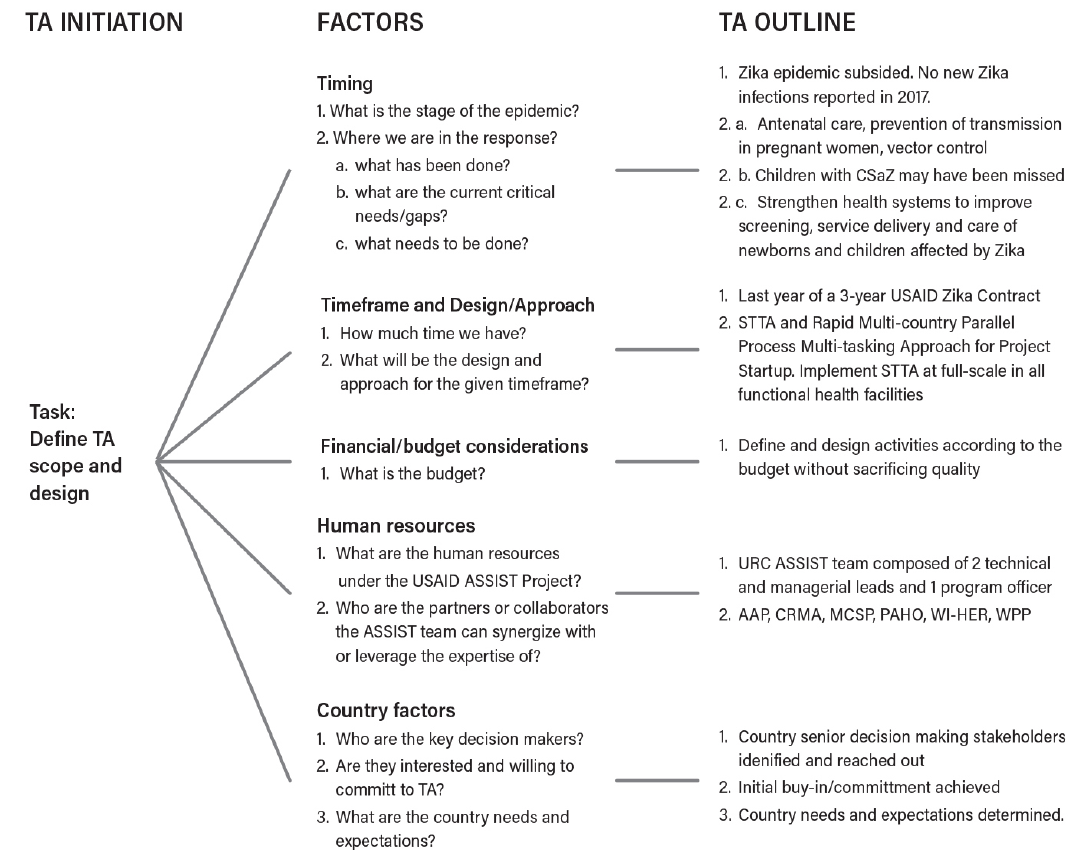
Figure 3. Key determining factors for the STTA focus, scope and approach. TA, technical assistance; CSaZ, congenital syndrome associated with Zika; STTA, short-term technical assistance; MCSP, USAID Maternal and Child Survival Program; AAP, American Academy of Pediatrics; CRMA, Caribbean Regional Midwives Association; PAHO, Pan American Health Organization; WI-HER LLC, Women Influencing Health, Education, and Rule of Law; URC, University Research Co., LLC; WPP, World Pediatric